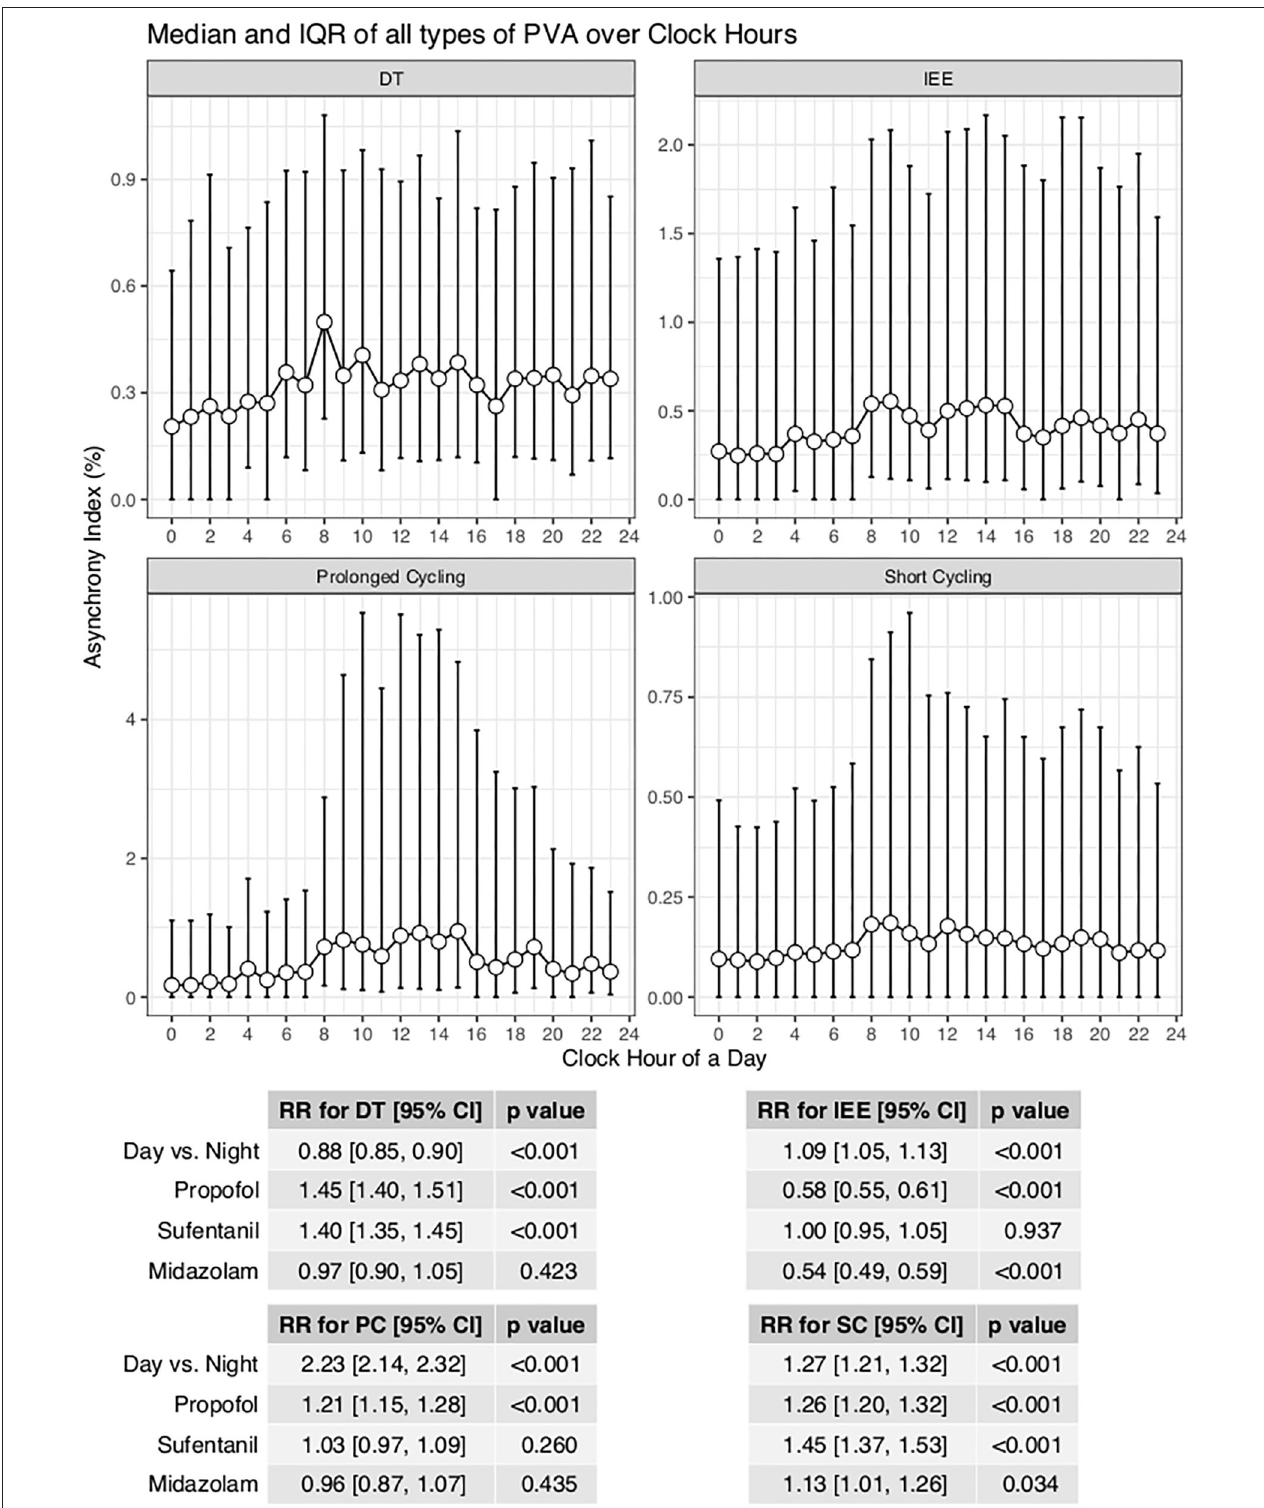
FIGURE 2 | Impact of day hours on four types of asynchrony. AI was defined as the percentage of respiratory cycles with the presence of relevant types of PVA. A negative binomial regression model was built to adjust for the confounding effect of analgesics and sedatives. IEE, ineffective effort; DT, double triggering; SC, short cycling, PC, prolonged